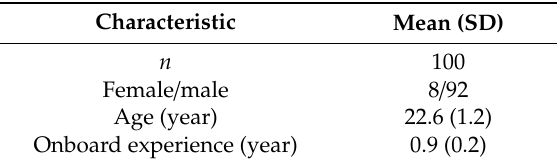
Table 2. Participant